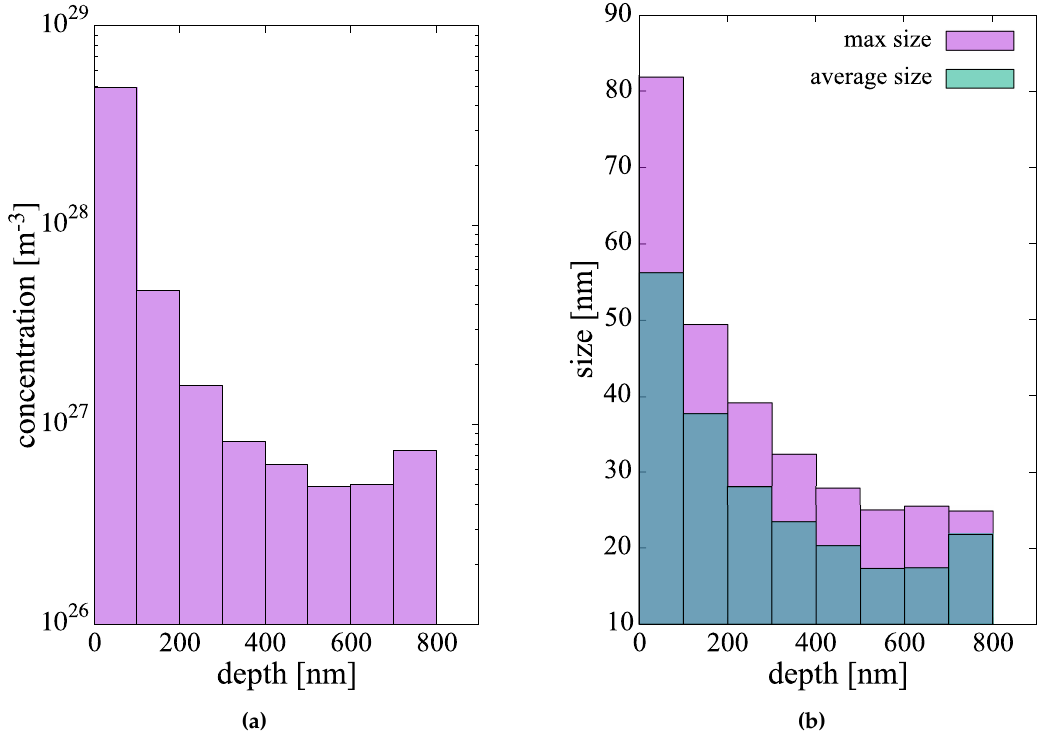
Figure 9. ( a ) Concentration profile and ( b ) size distributions of the hydride cluster population after 1.53 h of simulated